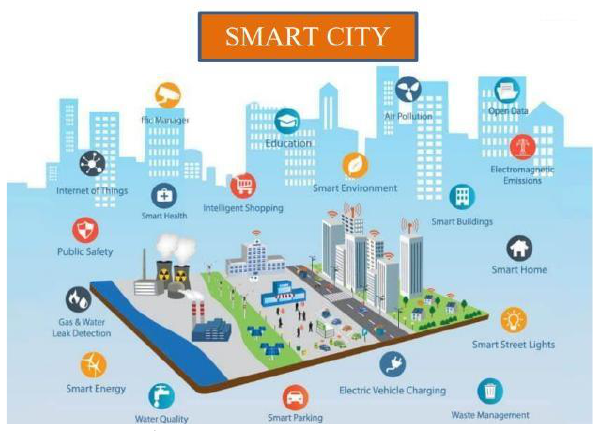
Figure 2. Smart Cities